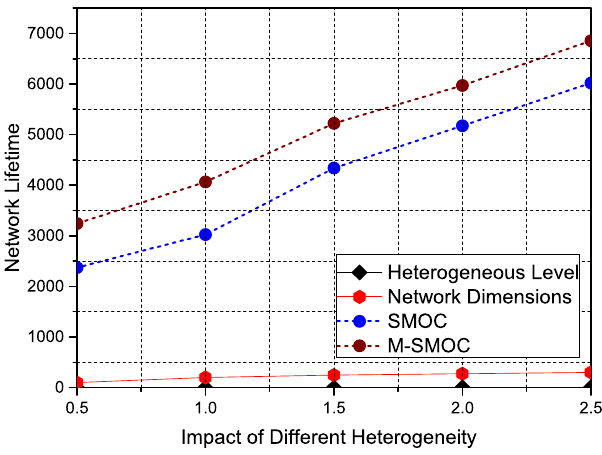
Figure 14. Comparison of the network lifetime of the proposed protocols with various sizes of